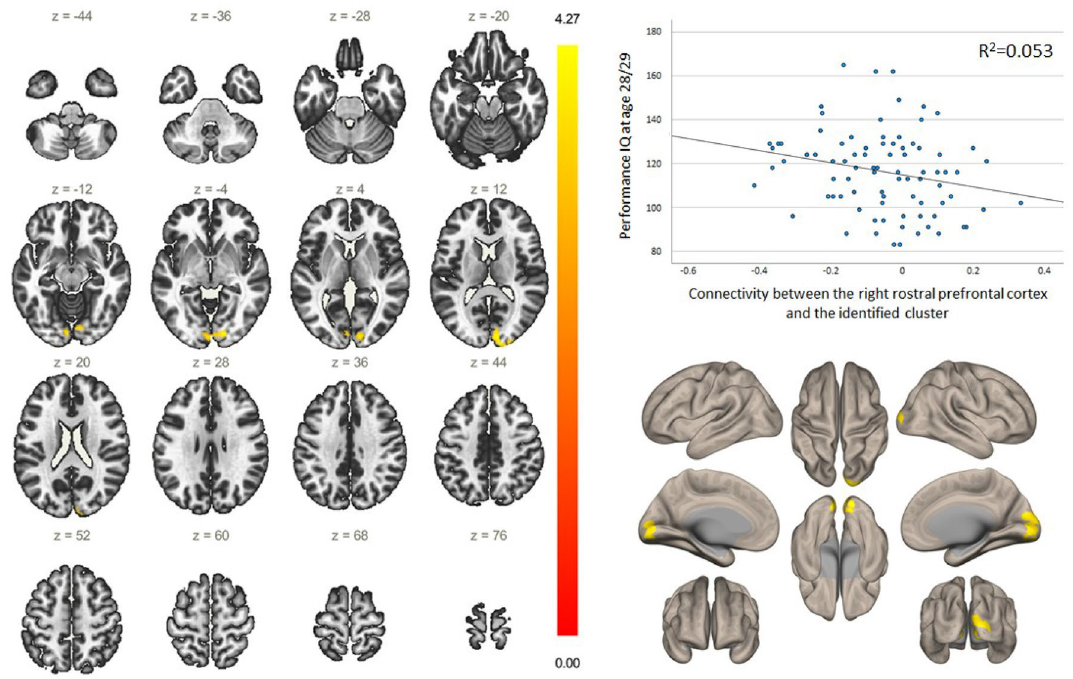
Figure 1. Functional connectivity of the right rostral prefrontal cortex and its relation to cognitive ability. Figures on the left and bottom right demonstrate in yellow a cluster of voxels (MNI + 14; − 88; − 06) correlating with the right rostral prefrontal cortex. The cluster includes right and left occipital pole, right and left lingual gyrus, right and left intracalcarine cortex, right occipital fusiform gyrus, right cuneal cortex and right supracalcarine